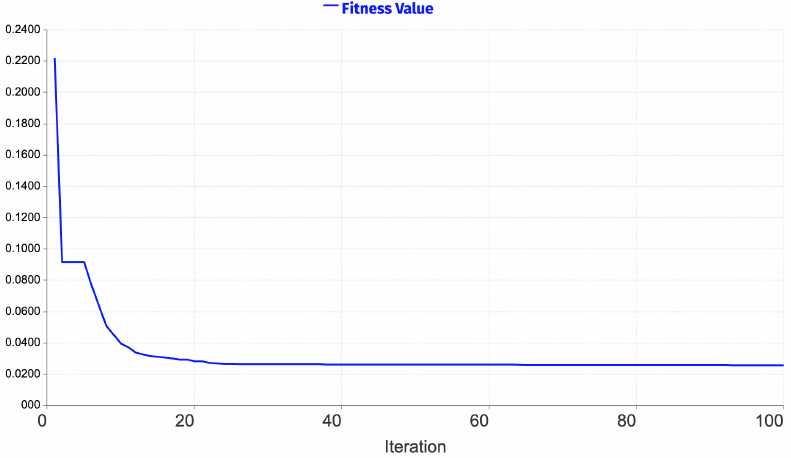
Figure A14. The training convergence curve when using the ANN with the PSO and the accuracy fitness function for the dataset of Polish